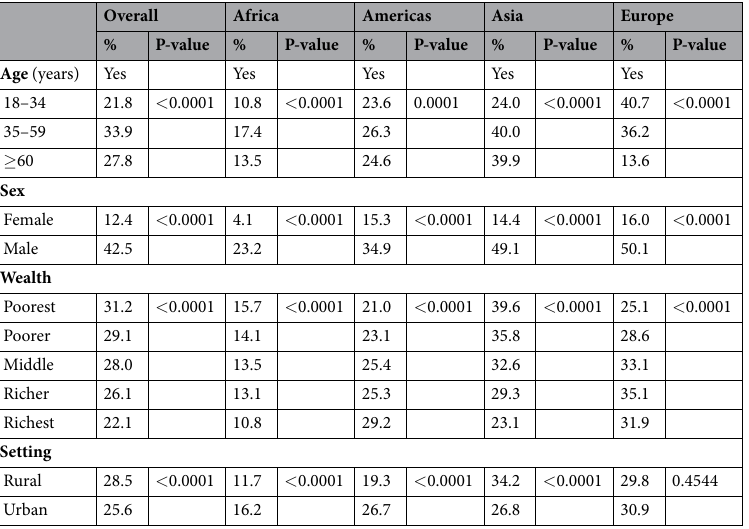
Table 2. Prevalence of smoking by sample characteristics. Percentages are based on weighted sample. The difference in the prevalence of smoking by sample characteristics was tested by Chi-squared